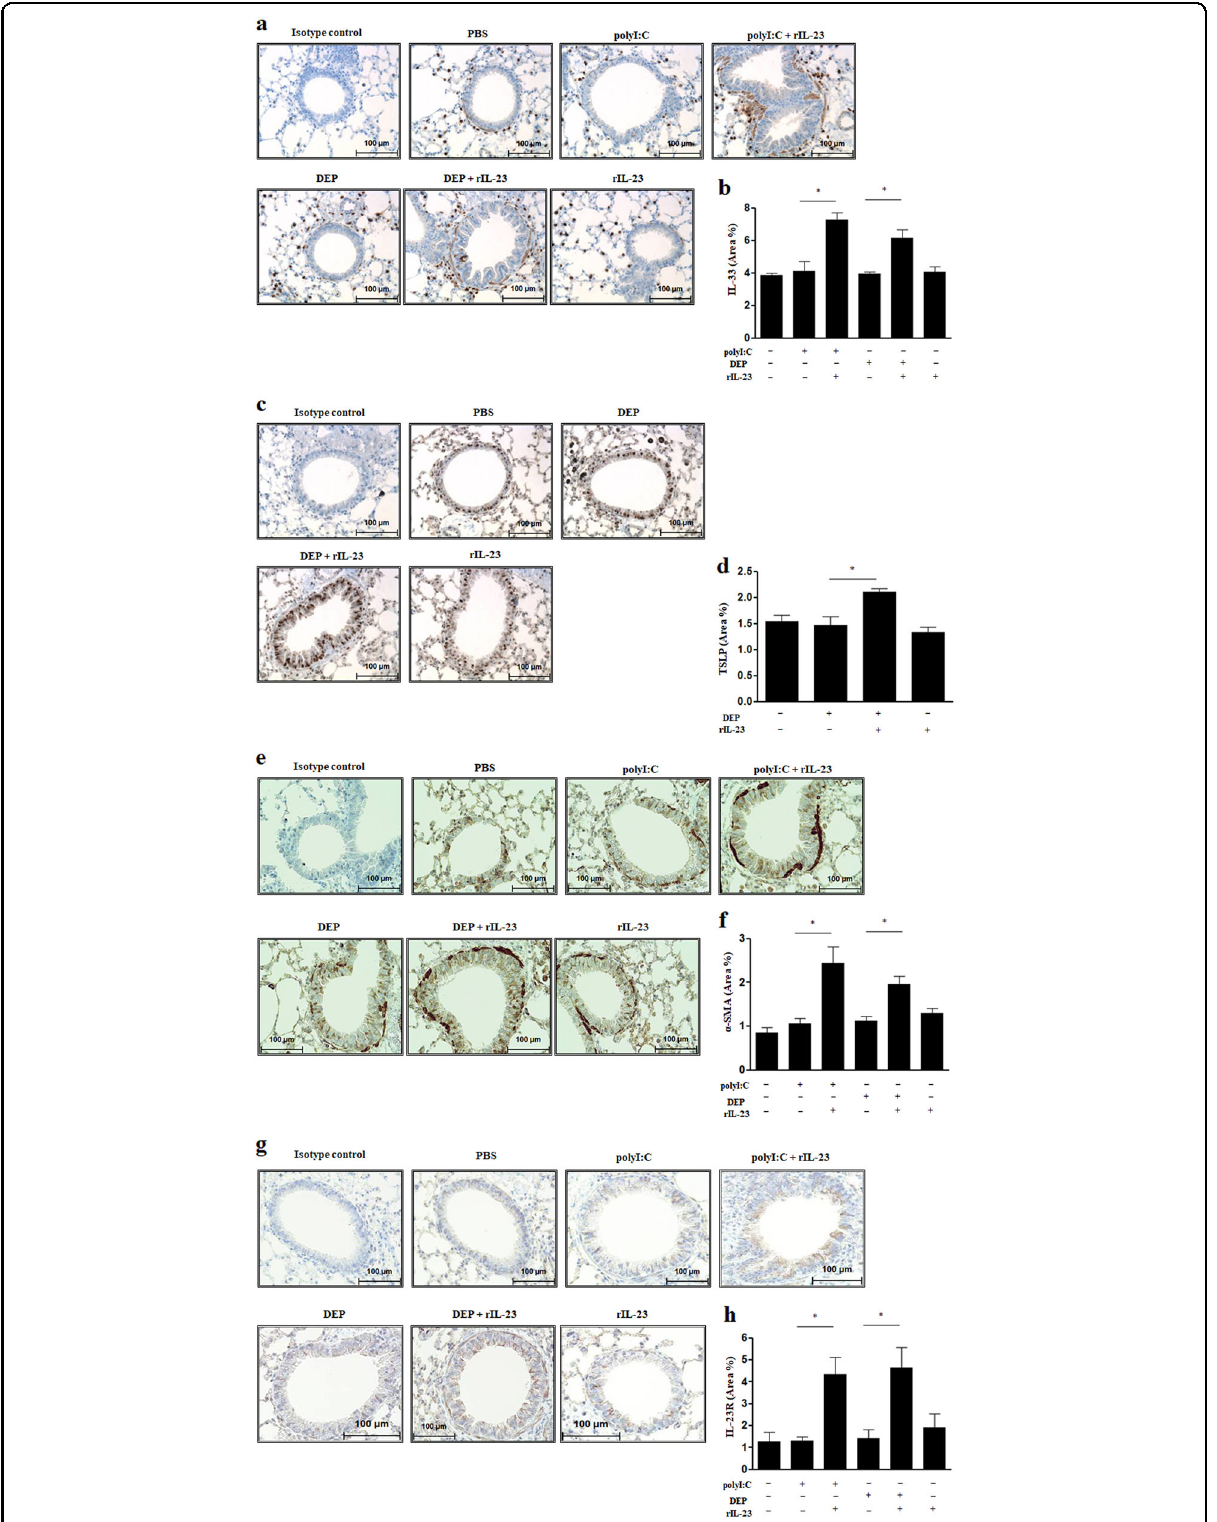
Fig. 4 Immunohistochemistry fi ndings. a IL-33. b Comparison of area% of IL-33. c TSLP. d Comparison of area% of TSLP. e α -SMA. f Comparison of area% of α -SMA. g IL-23R. h Comparison of area% of IL-23R. Magni fi cation, ×40. Area% was quanti fi ed using ImageJ software. * P < 0.05 between two groups. DEP diesel exhaust particle; α -SMA alpha-smooth muscle actin; PBS phosphate-buffered